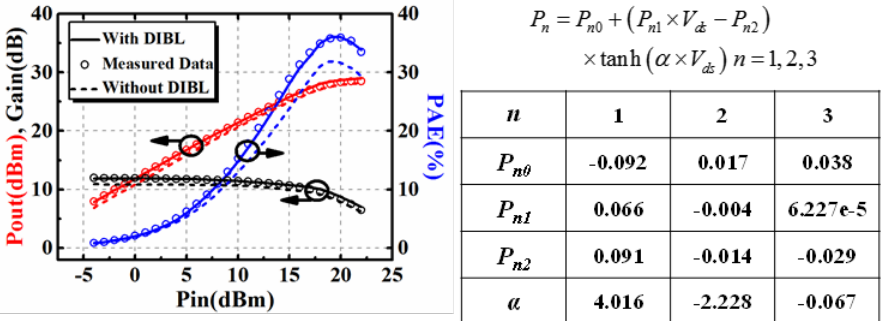
Figure 11. Investigation on the influence brought by DIBL effect on large signal performance.